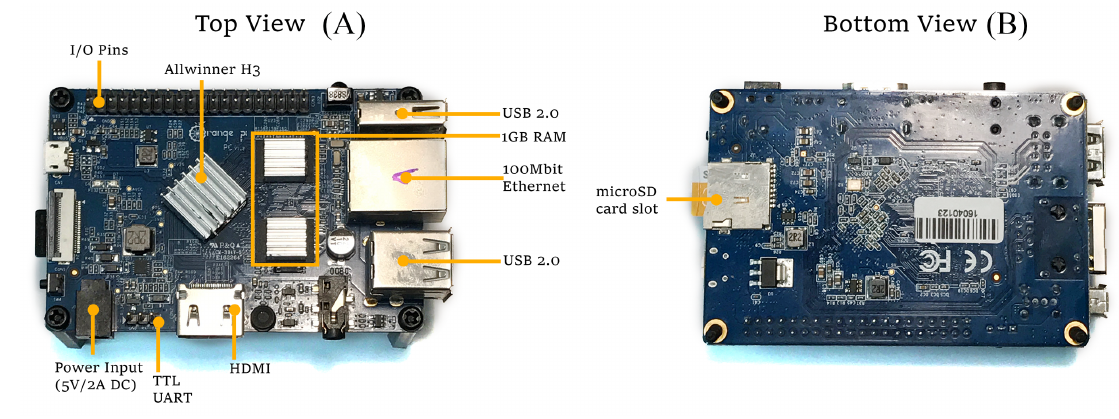
Figure 4. Orange Pi PC Printed Circuit Board (PCB). Top view ( A ) and bottom view ( B